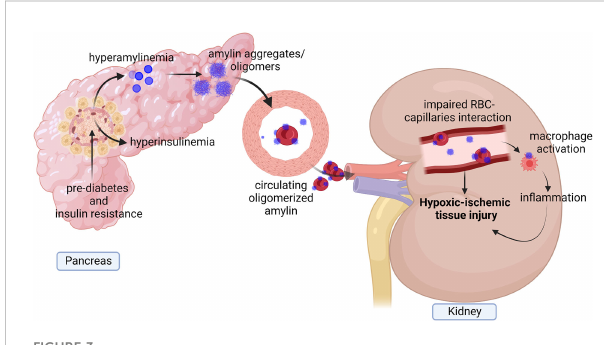
FIGURE 3 Diagram showing diabetes associate hyperamylinemia increases hypoxia signaling and in fl ammation in kidney. Prediabetes associated hyperamylinemia promotes aggregation of human amylin in pancreas. Human amylin aggregates also reach to circulation where they deposited in microvasculature and on Red blood cells (RBCs) leading to reduced RBCs capillaries interaction. Accumulation of human amylin aggregates in renal tissues and microvasculature promote elevation of EPO level, hypoxia markers and in fl ammation causing hypoxic injury of renal